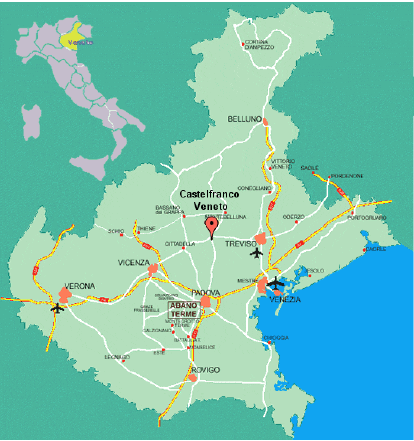
Figure 1: Geographic location of Castelfranco Veneto, Italy